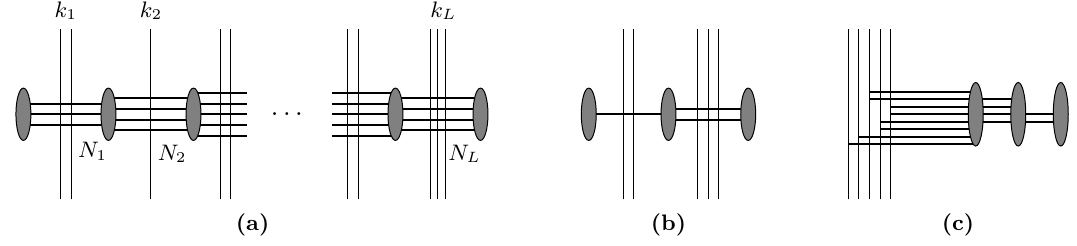
Figure 1. Left: brane setups for 3d quiver gauge theories. D3-branes are shown as horizontal lines, NS5-branes as ellipses and D5-branes as vertical lines. Figure 1b: [2] − U(1) − U(2) − [3] theory. Moving D5-branes to one side and NS5-branes to the other, taking into account